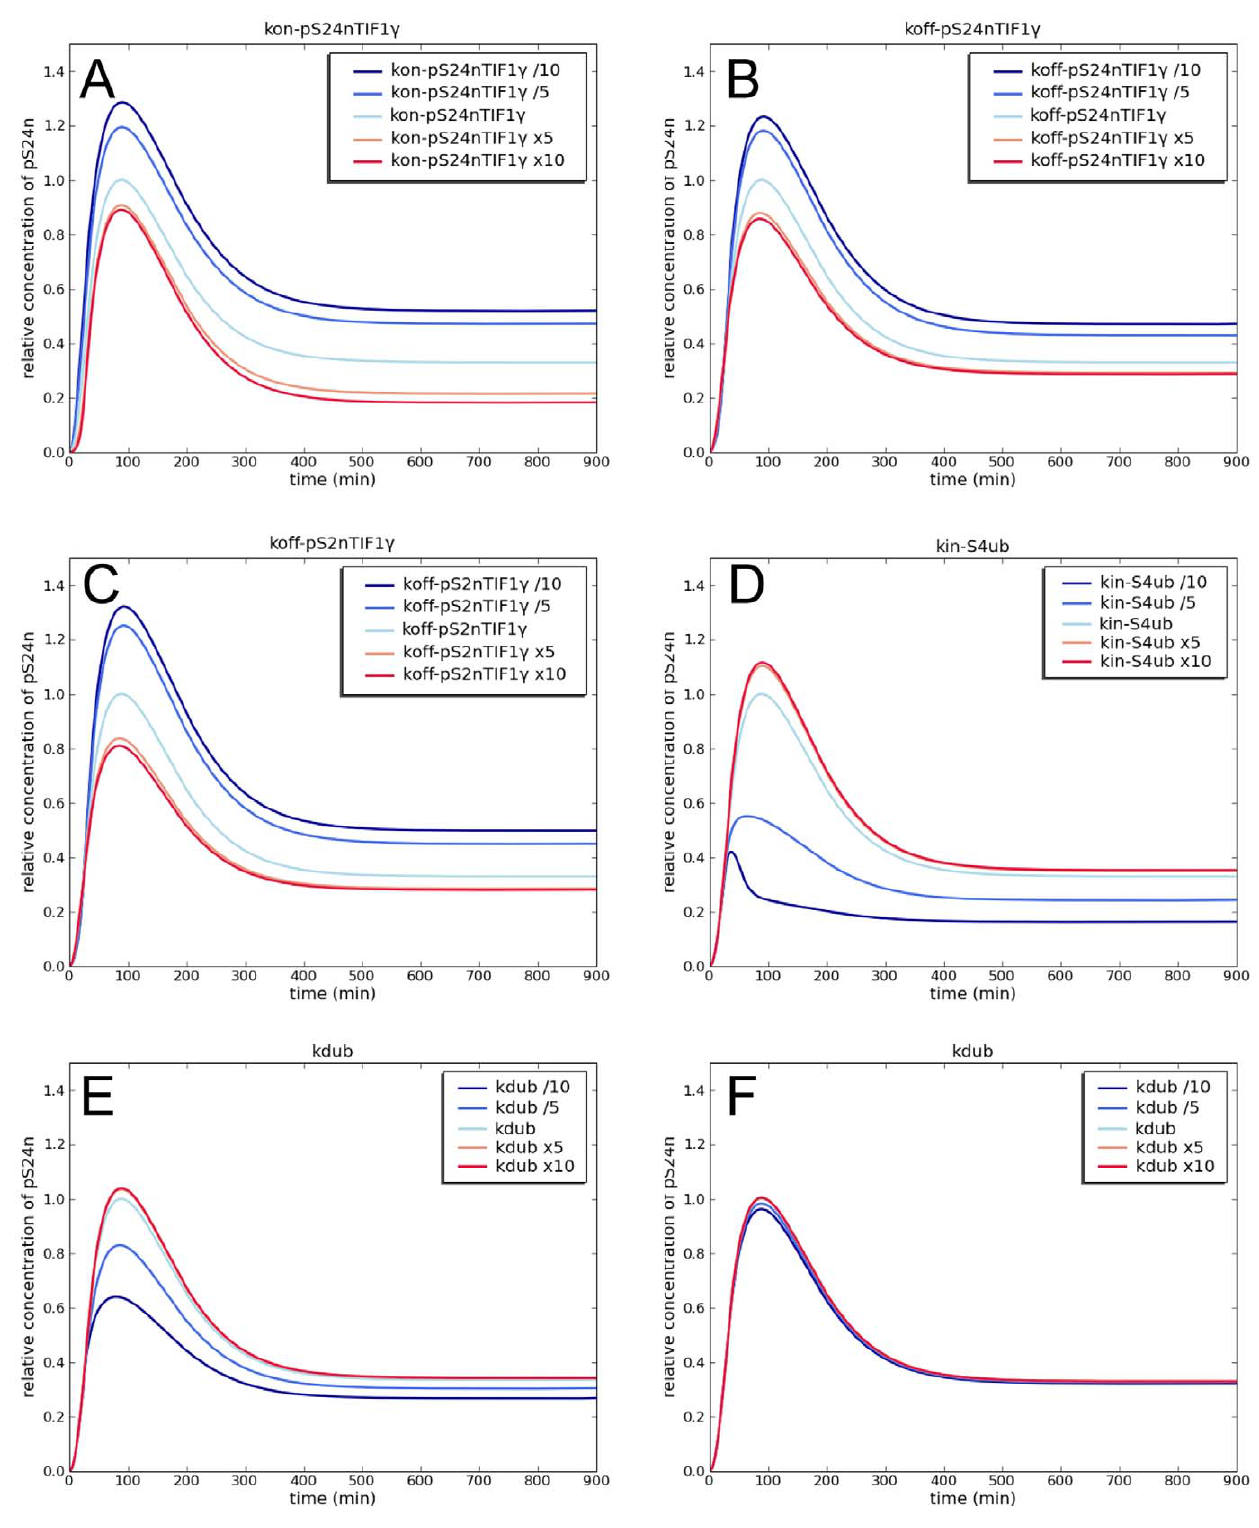
Figure 3. Parameter sensitivity analysis. Modeling analysis of pS24n response to variations of kinetic constants at a 10 nM TGF- b input. A) k on - pS24nTIF1 c , binding of TIF1 c to phosphorylated-Smad2/Smad4 complexes; B) k off -pS24nTIF1 c , dissociation of phosphorylated-Smad2/Smad4/TIF1 c complexes in the nucleus; C) k off -pS2nTIF1 c , dissociation of phosphorylated Smad2-TIF1 c complexes in the nucleus; D) k in -S4ub, nuclear export of ubiquitinated Smad4 in the cytoplasm; E) and F) k dub , deubiquitination of Smad4 according to relative FAM concentrations of 1 nM (E) and 10 nM (F).